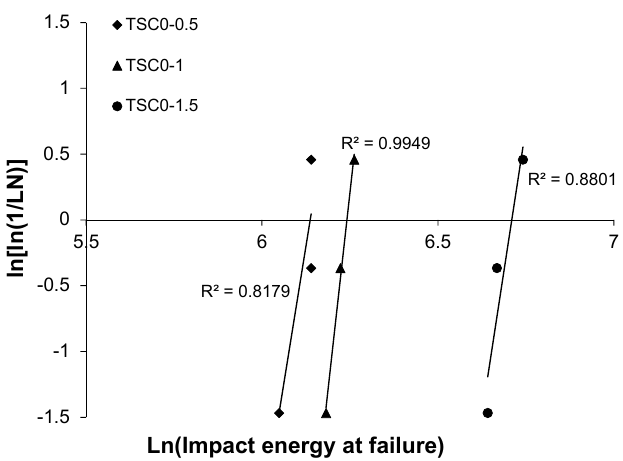
Figure 10. Weibull distribution of steel wires for the TSC specimens.